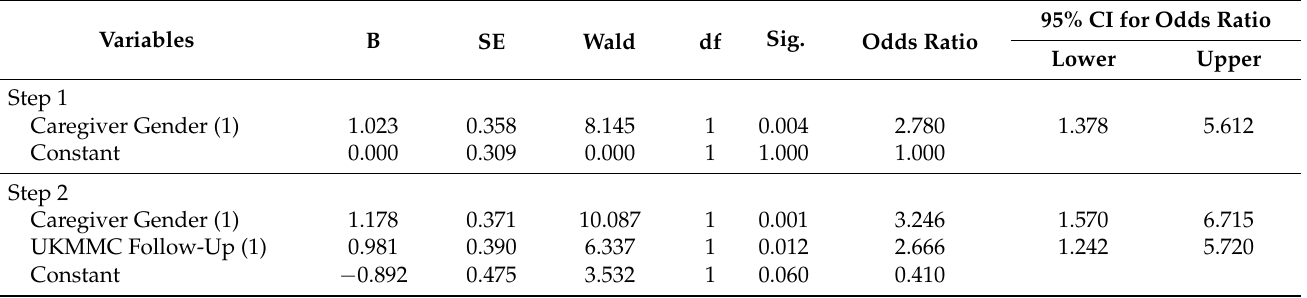
Table 7. Multiple logistic regression model to predict missed appointment among the caregivers in the study population ( n =